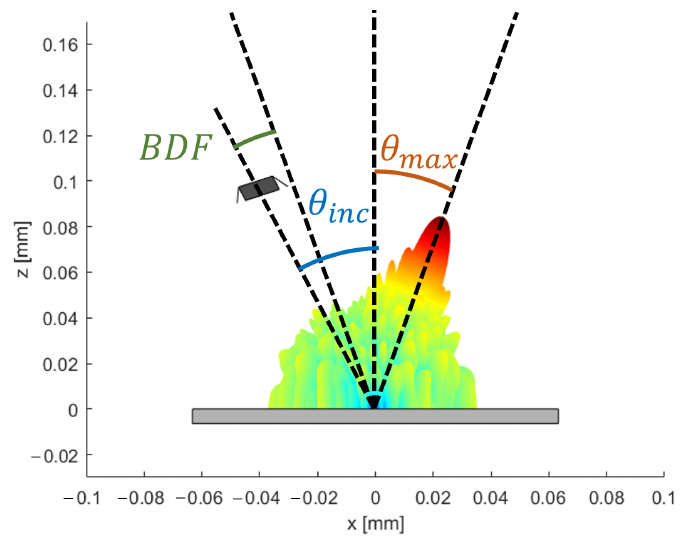
Figure 3. Definition of Beam Deviation